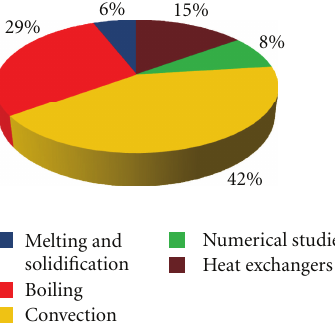
Figure 8: Increase in convection heat transfer coe ffi cient versus ultrasonic power.